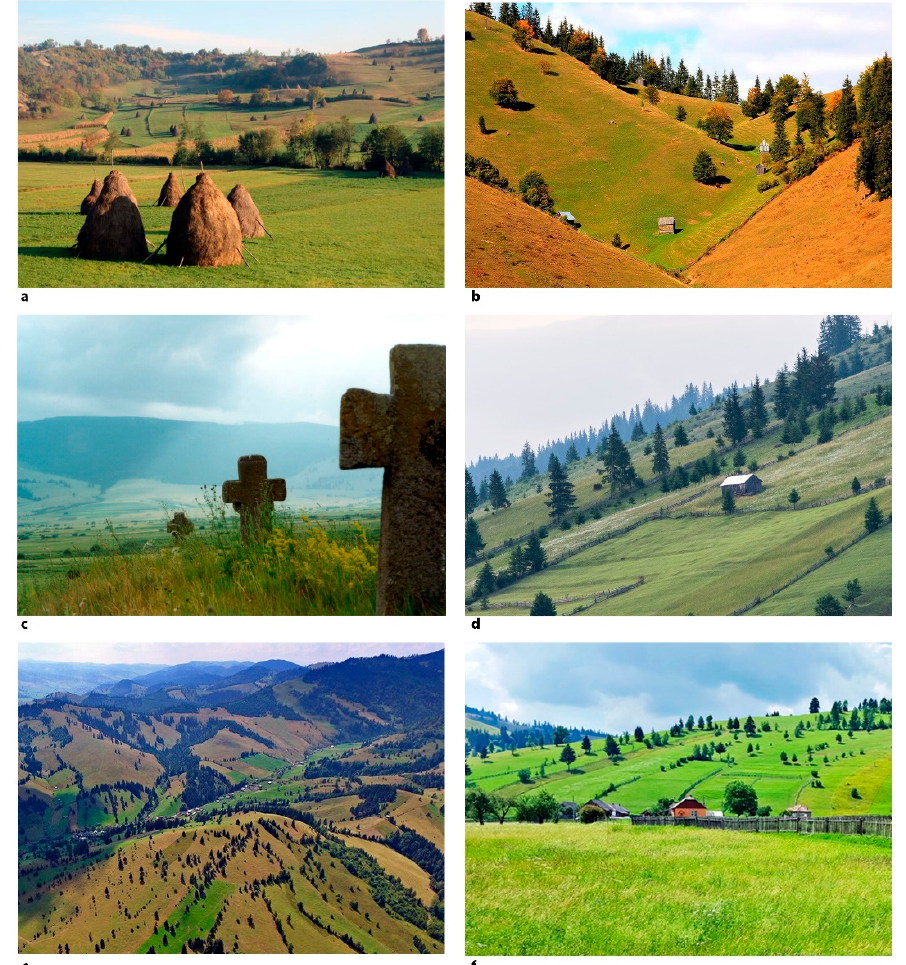
Figure 2. Landscape and land use in Szeklerland. Source: photos by the authors ( a , b , e , f ) and by Ars Topia Foundation ( c , d ). The figures show the mosaic-like landscape shaped by traditional use of parcels (grassland, meadow) and the land occupation typical for mountain villages.